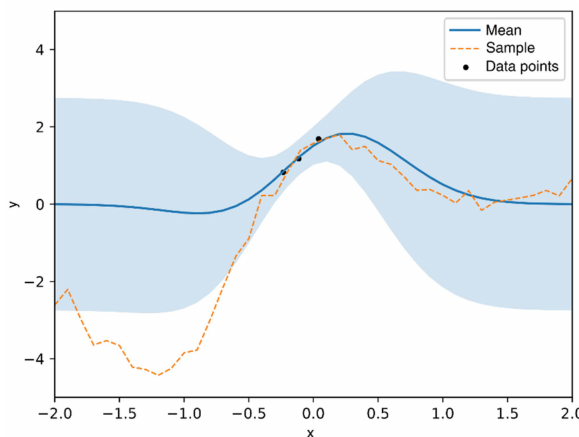
Figure 8. An illustration of GPR and how more data increases the predictive capabilities.